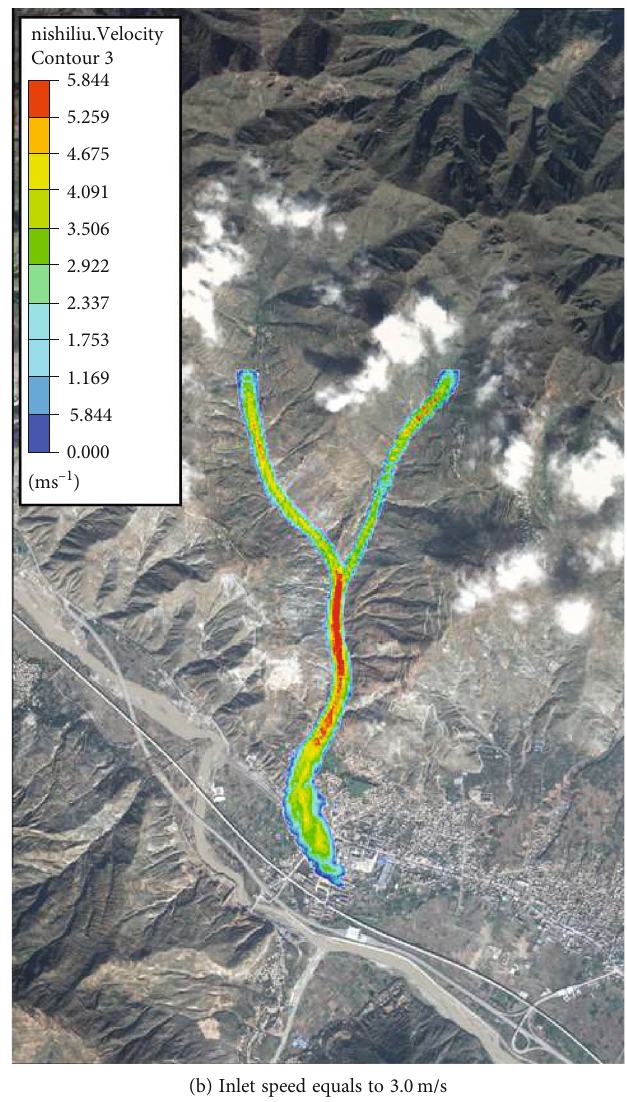
Figure 6: Velocity contour on free surface with satellite image of Niwan